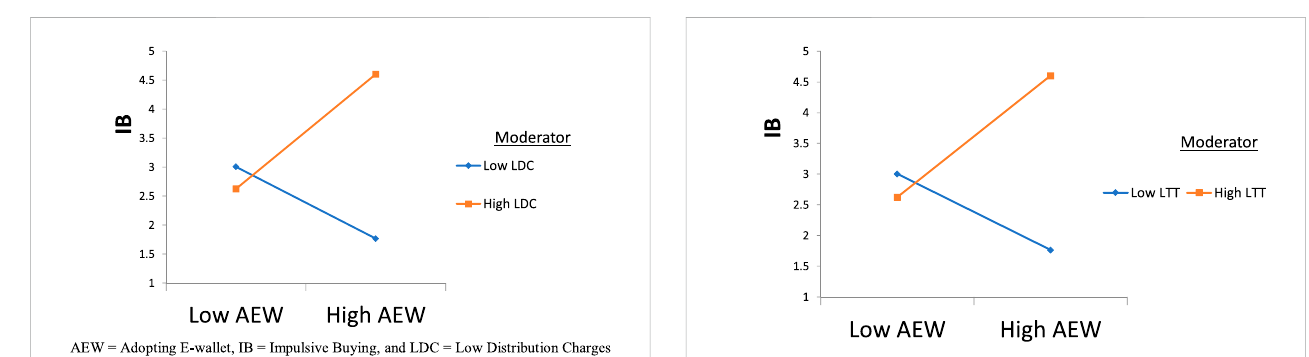
FIGURE 5 Moderation LTT - > IB. AEW, Adopting E-wallet; IB, Impulsive Buying, and LTT, Low Transit